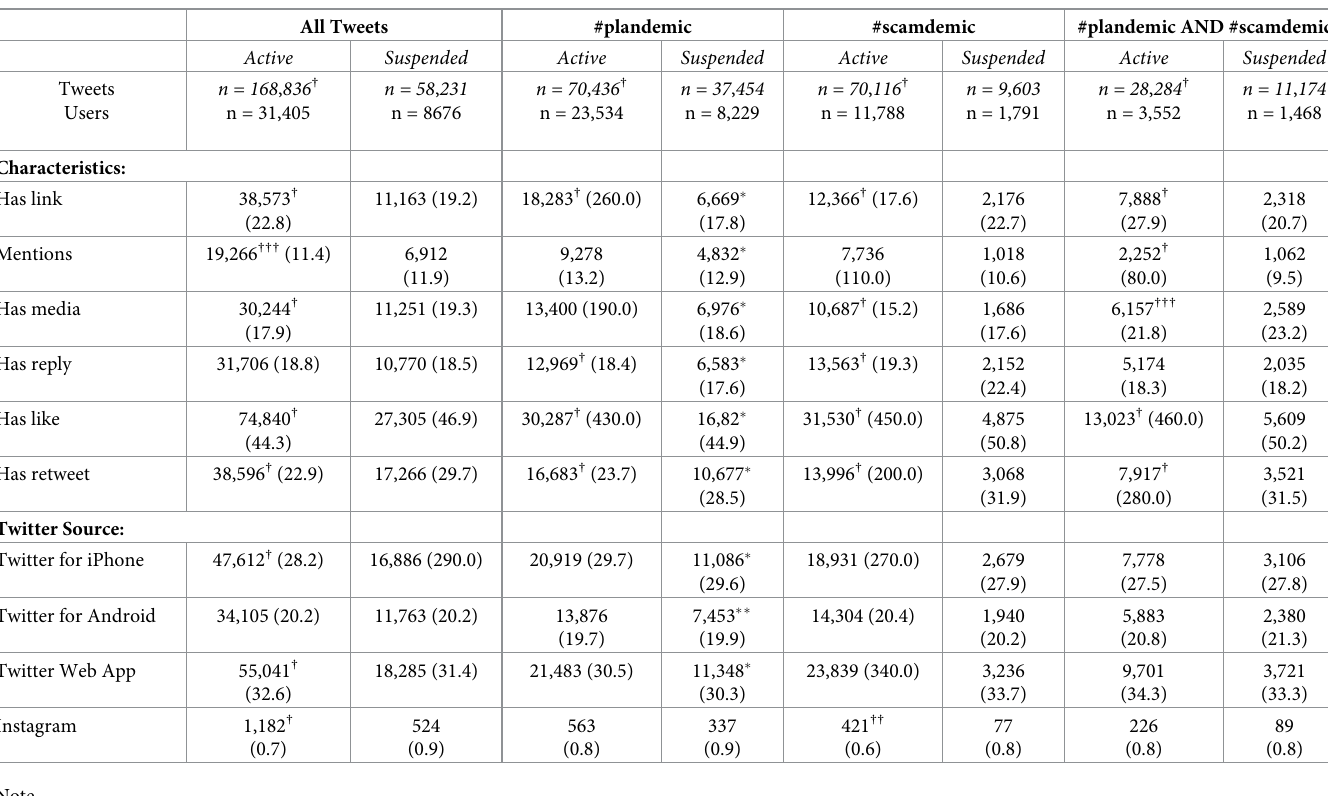
Table 2. Characteristics of